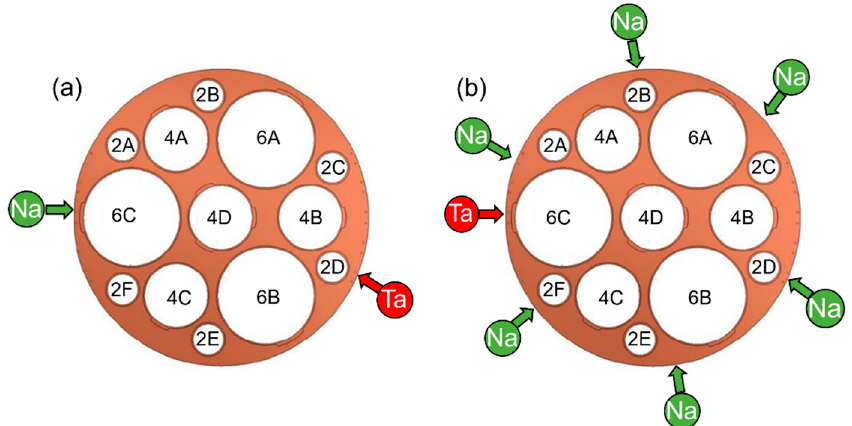
Figure 1. Schematics of the used deposition configurations: ( a ) 1-1 and ( b ) 1-6, where the red and green arrows show the angular positions of the active sources of tantalum and sodium, respectively. The sample holder (big circle, 450 mm) is able to accommodate 2” substrates (positions 2A, 2B, 2C, 2D, 2E, and 2F), 4” substrates (positions 4A, 4C, 4D, and 4B) and 6” substrates (positions 6C, 6B, and 6A). Table 1. List of the deposition